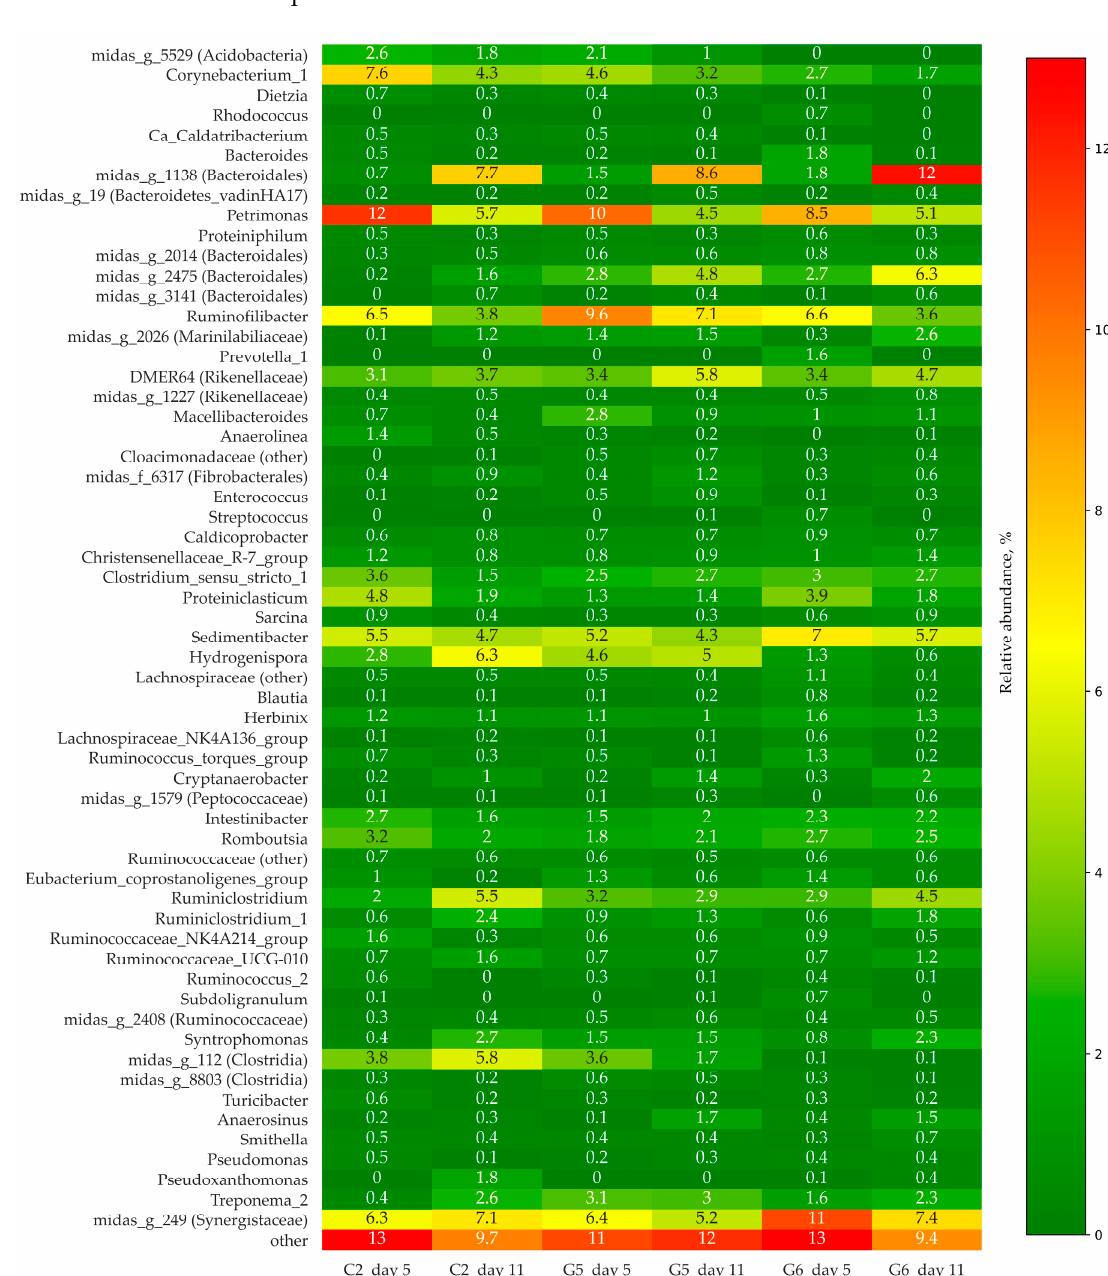
Figure 5. Taxonomic composition of bacterial communities in reactors C2, G5, and G6 (sampled on days 5 and 11). Bacterial community composition according to amplicon sequencing of the bacterial 16S rRNA gene is shown on the class level. Only classes with a relative abundance of at least 1% in at least one sample are presented.